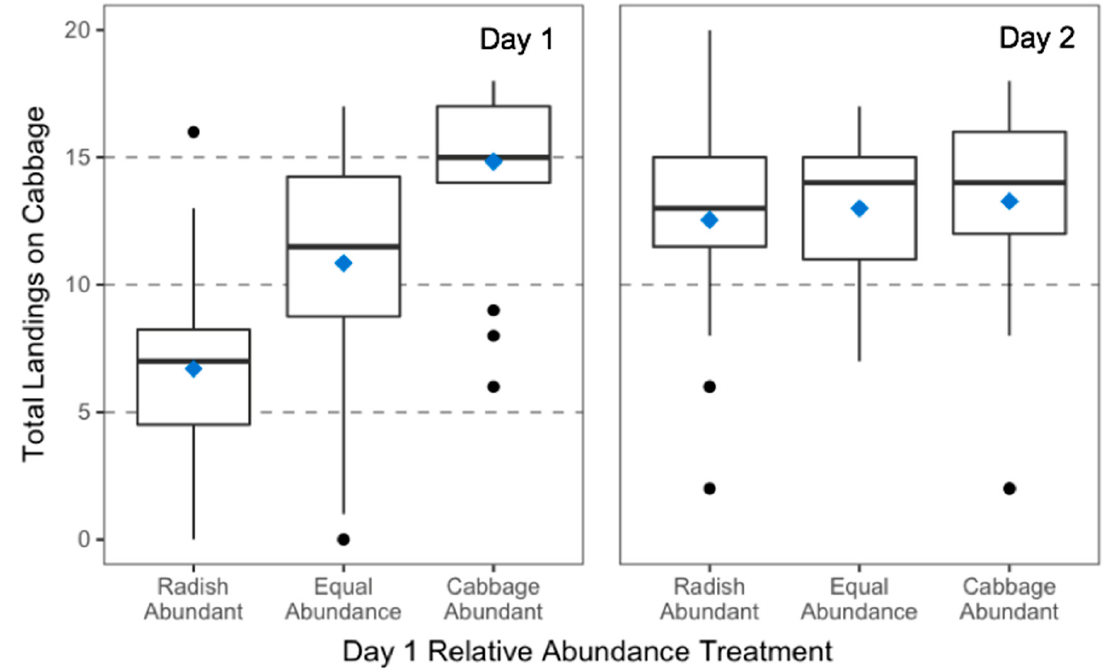
Figure 2. Total landings on cabbage made by butterflies that experienced different relative host abundances of cabbage and radish on Day 1 and a common environment with equal abundance of both hosts on Day 2. Box plots are constructed using the median (center line) and first and third quartiles (lower and upper lines respectively). Whiskers extend to the largest value no further than 1.5*IQR. Blue diamonds represent means and dots represent outlying points plotted individually. Dashed lines represent the expected number of cabbage landings based on the proportion of cabbages in the environment: 15 for cabbage-abundant, 10 for equal abundance, and 5 for radish-abundant environments. Note: This graph differs from our analysis, which used binomial regression to model cabbage (1) and radish (0) landings.